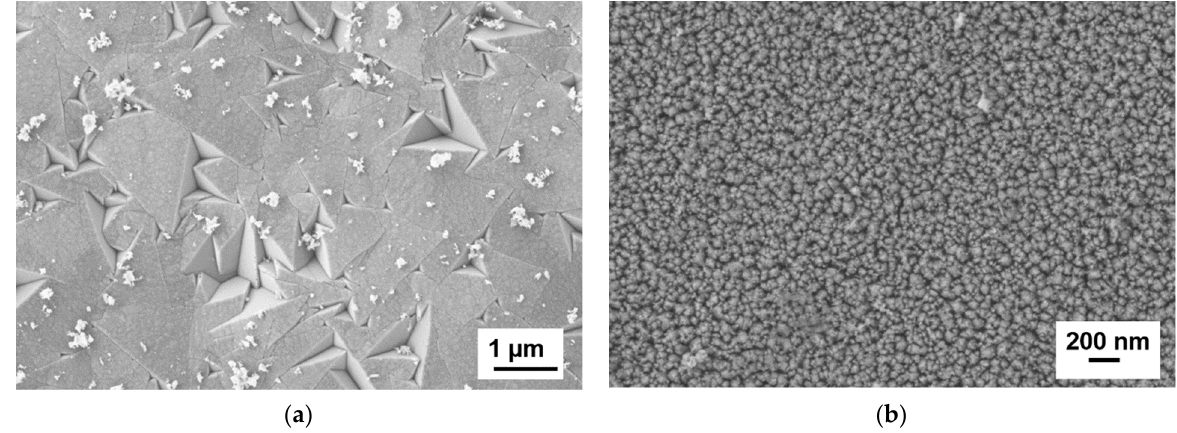
Figure 5. SEM images of a flake of the free-standing Ti 1 − x Al x N layer: ( a ) top side; ( b ) bottom side. The bottom side has a nanocrystalline structure and the top side (the surface